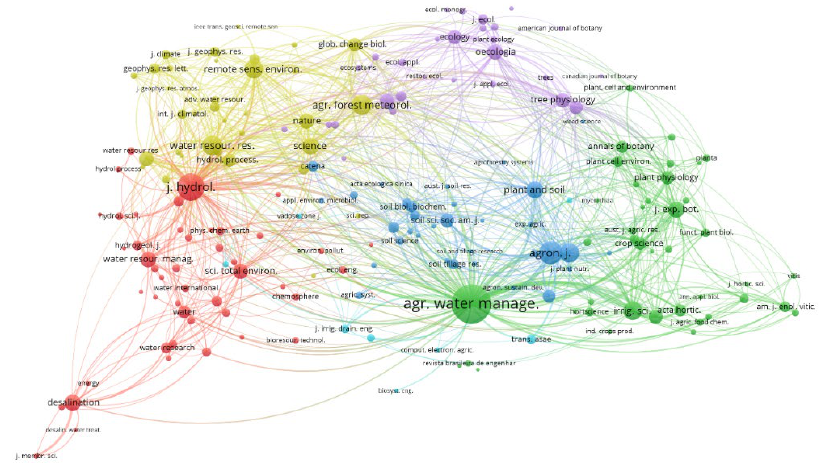
Figure 7. Network of co-citation of journals. Cluster 1 (red colour), cluster 2 (green colour), cluster 3 (blue colour), cluster 4 (yellow colour), cluster 5 (purple colour), cluster 6 (light blue colour).